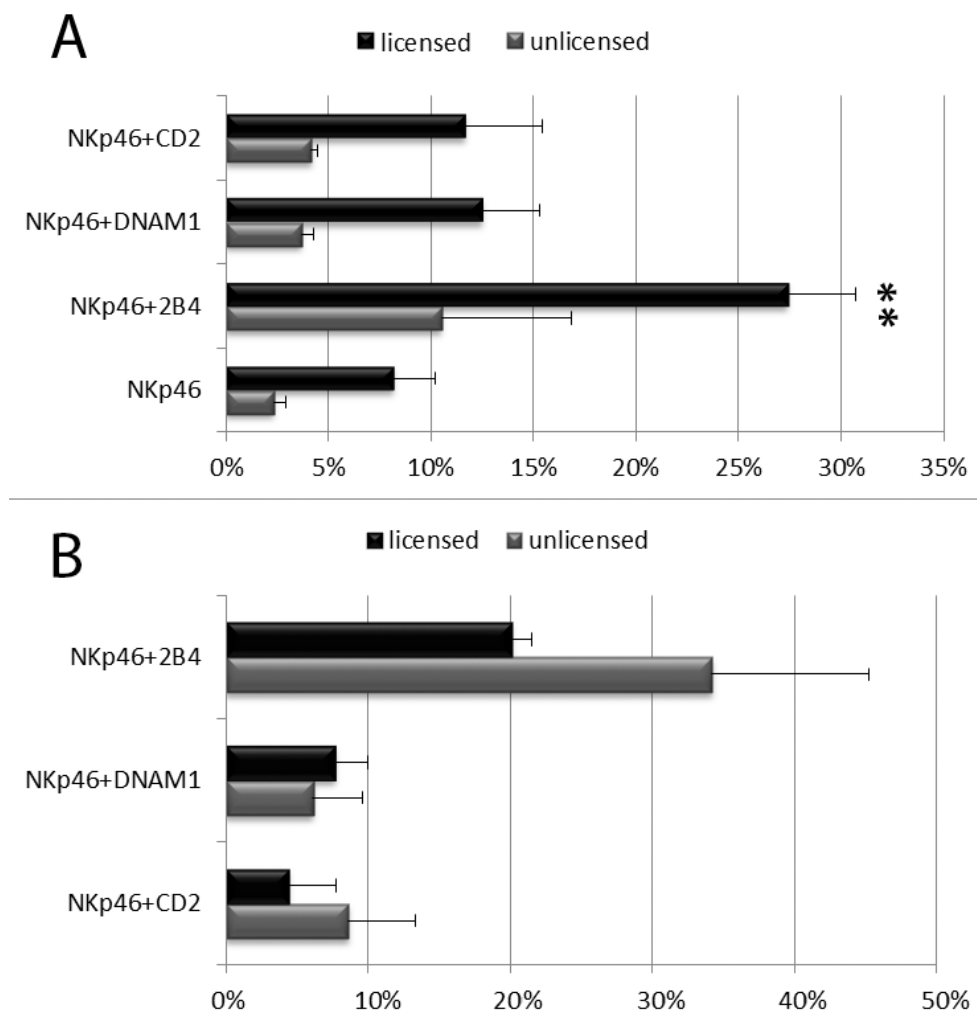
Figure 4. Degranulation analysis of resting licensed and unlicensed CD56 dim NK cells after stimulation with the indicated mAb combinations. ( A ) Percentages of degranulating NK cells. ( B ) Percentage increment of CD107a mean fluorescent intensity on degranulating NK cells stimulated with the indicated combinations respect to anti-NKp46 alone. Data represent mean +/- SD of at least 5 experiments. Bars indicate SD. * p < 0.05 relative to NK cells stimulated with anti-NKp46 mAb-coated beads within its NK cell subset. (** They are two different *, referred to two different close columns)